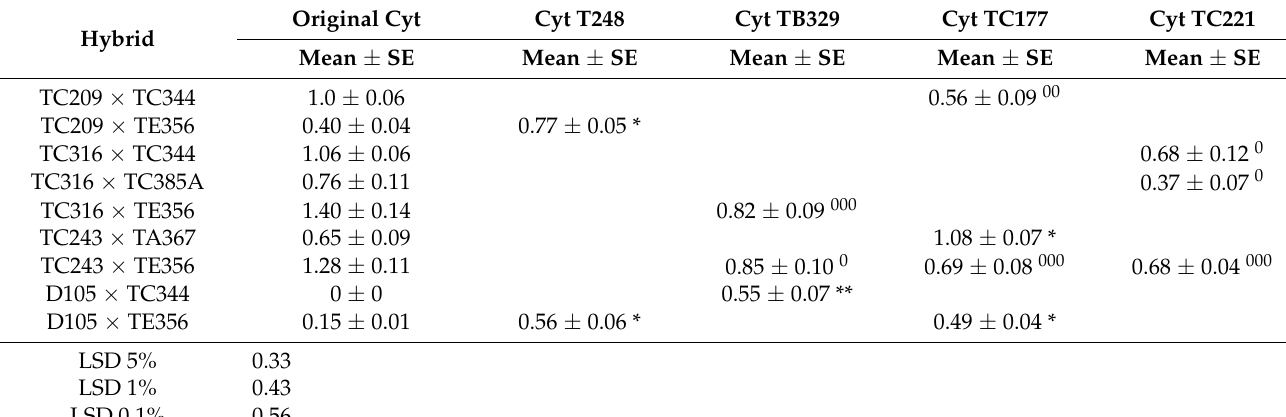
Table 10. The influence of cytoplasm × nucleus × tester interaction on some hybrids β -carotene content ( µ g/g)—ANOVA test.